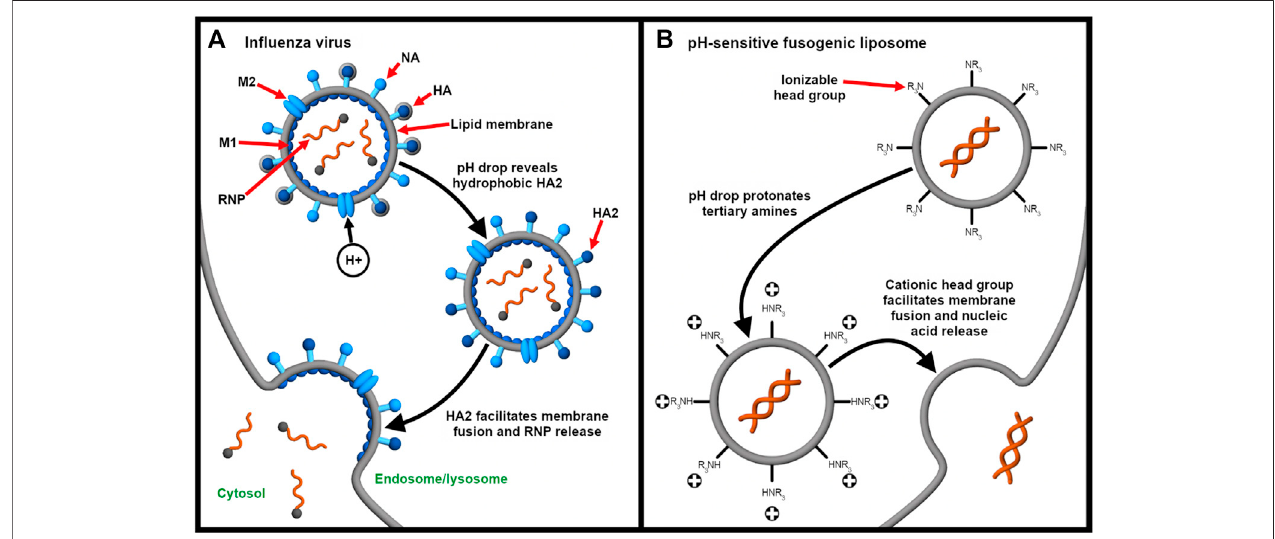
FIGURE 4 | Endocytosis provides an opportunity for integrating stimulus-responsive nucleic acid release. (A) The in fl uenza virus releases its genome (complexed with nucleoproteins, gray spheres) into the cytosol in a pH-dependent manner. Endosomal acidi fi cation drives the in fl ux of protons through the Matrix Protein 2 (M2) ionophore. This liberates the ribonucleoprotein (RNP) complex from Matrix Protein 1 (M1) and exposes the fusogenic subunit HA2, which, in turn, facilitates fusion of the viralandendosomalmembranes(Pintoetal.,1992).Neuraminidase(NA)enablesreleaseofthein fl uenzavirusfromthehostcellafterreplication(JamesandWhitley 2017). (B) Ontheotherhand, pH-responsive fusogenic liposomes arecomposed ofionizablelipidswithweaklybasichead groupsthatare rapidlyprotonatedasthe pH dropsin theendosomes.This enables theprotonatedlipids topromote fusion and nucleic acid release before lysosomaldegradation (Budker et al.,1996; Kogure et al., 2008; Sato et al.,